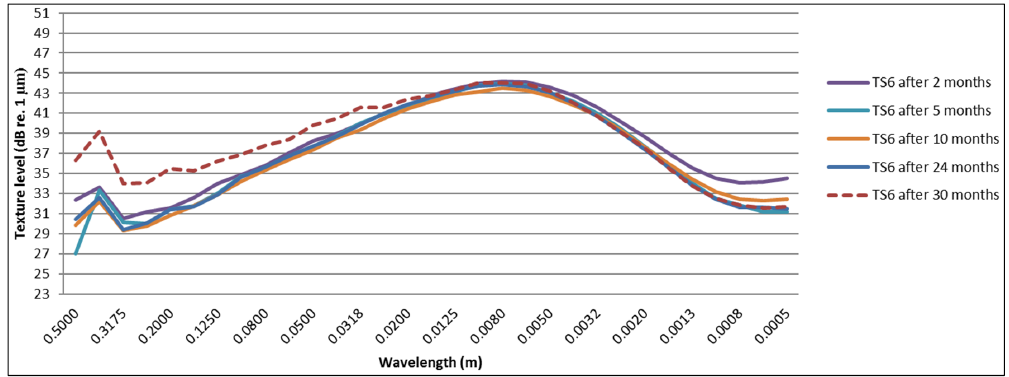
Figure 16. Change in texture spectra over a period of 30 months for Test Section 6.